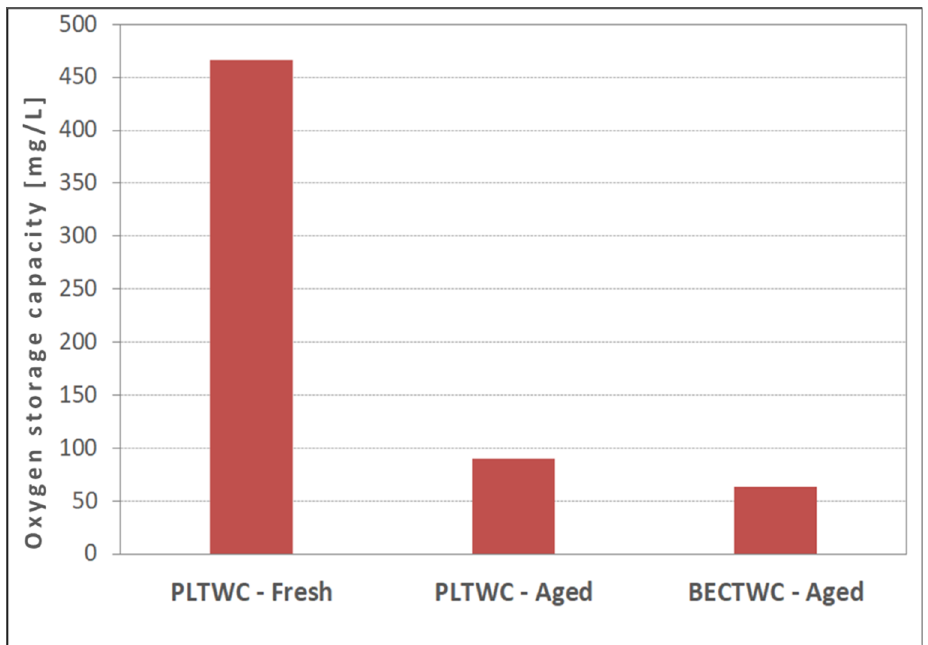
Figure 8. TWC test: Oxygen Storage Capacity (average values).